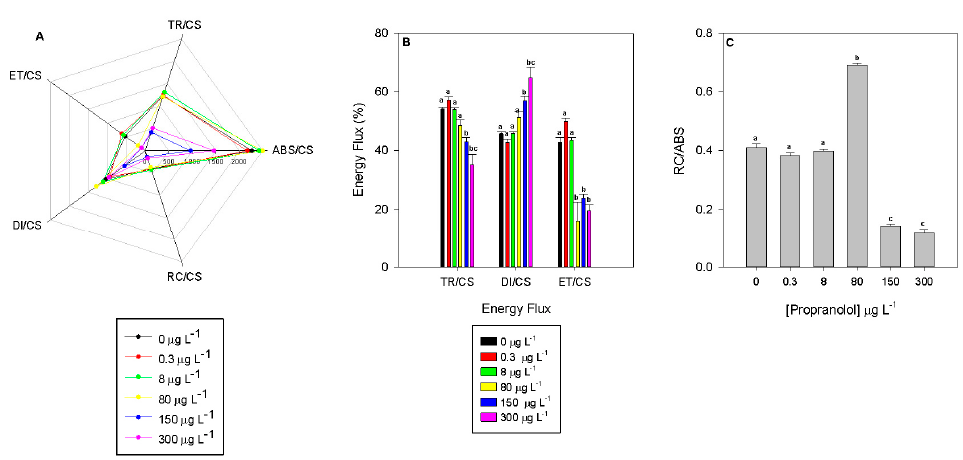
higher relative dissipated energy flux in these same cultures (r 2 = 0.93, p < 0.05). The significant